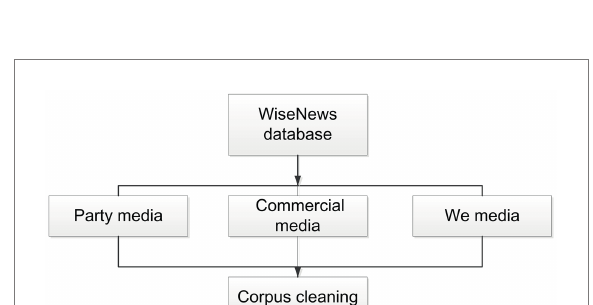
FIGURE 1 Five stages of fighting COVID-19 in China.